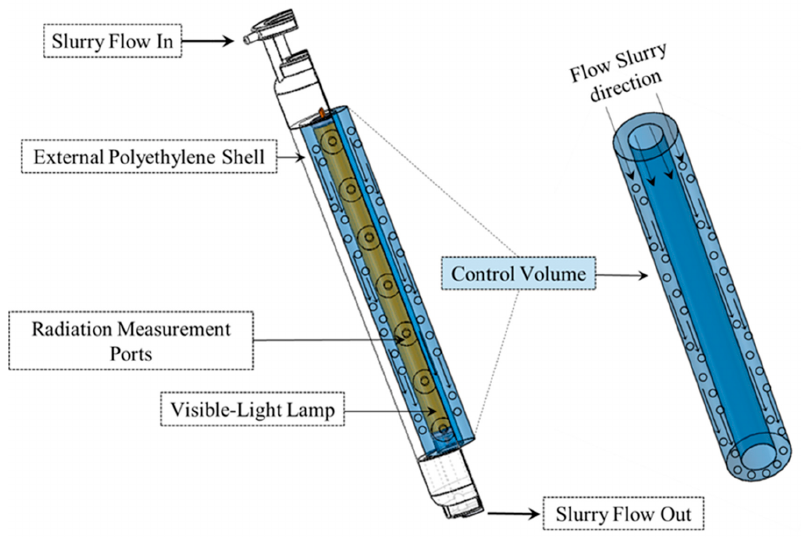
Figure 6. Schematic Representation of the 6000 cm 3 Slurry Control Volume Involved in the Macroscopic Radiation